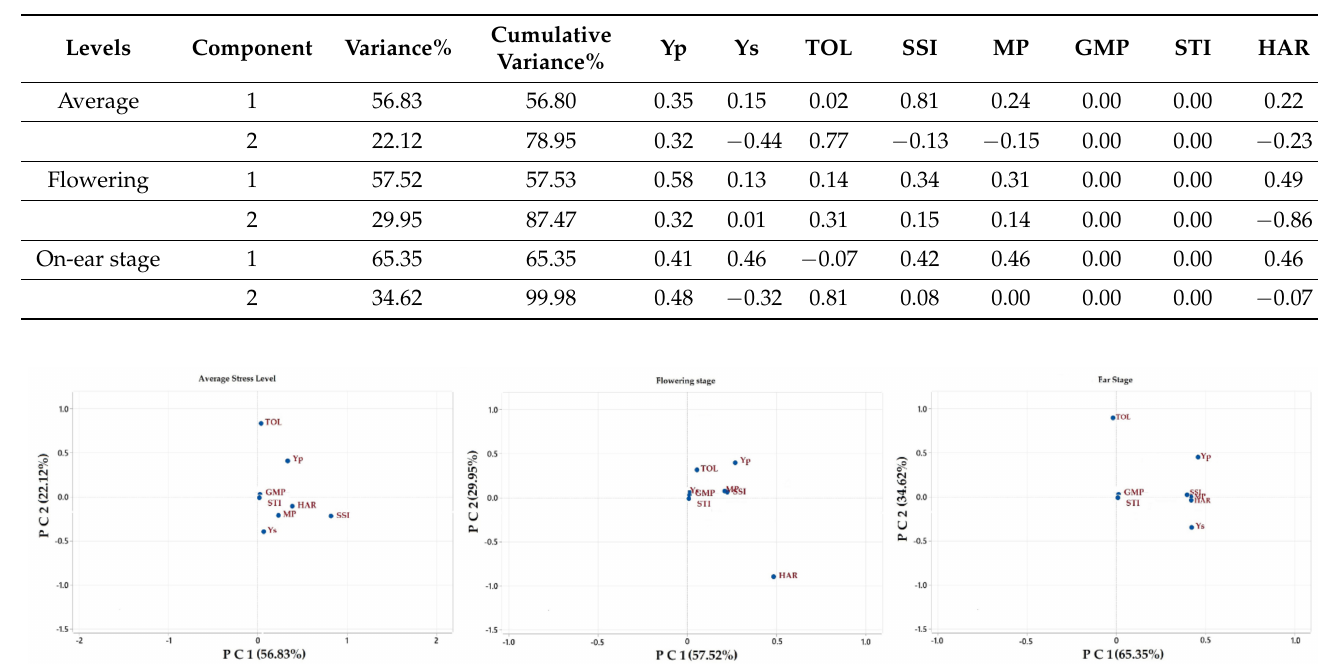
Table 8. Principal components analysis of drought-stress and yield indices.